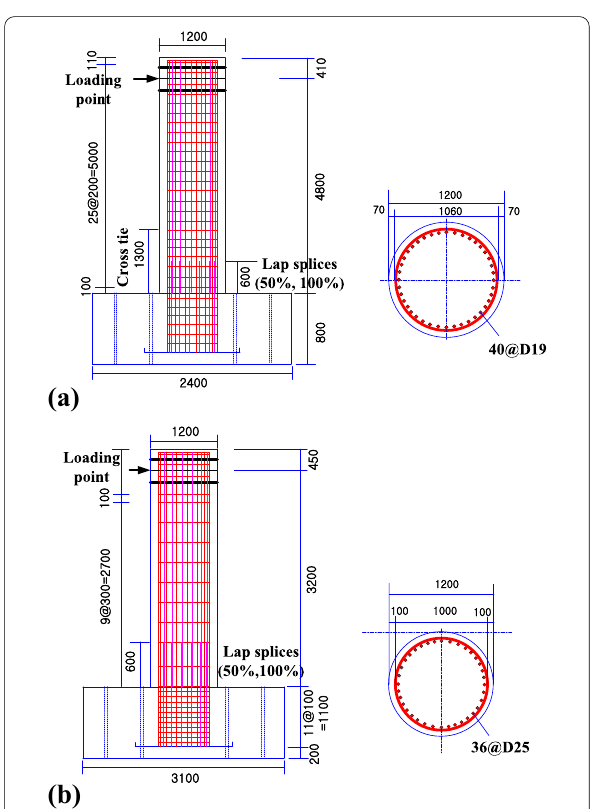
Fig. 7 Details of specimens (Unit: mm): a NS series and b FS series.